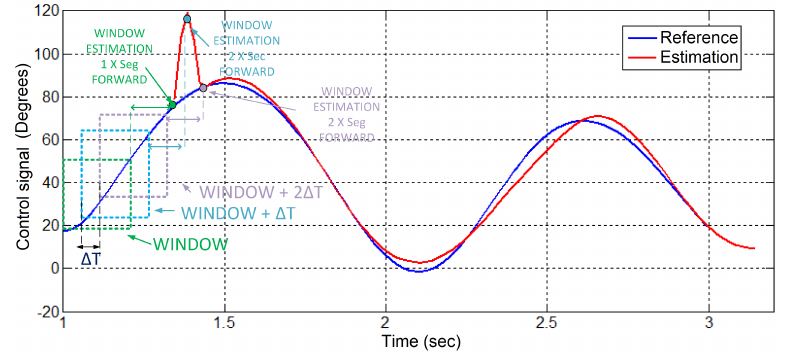
Figure A1. Estimation of reference